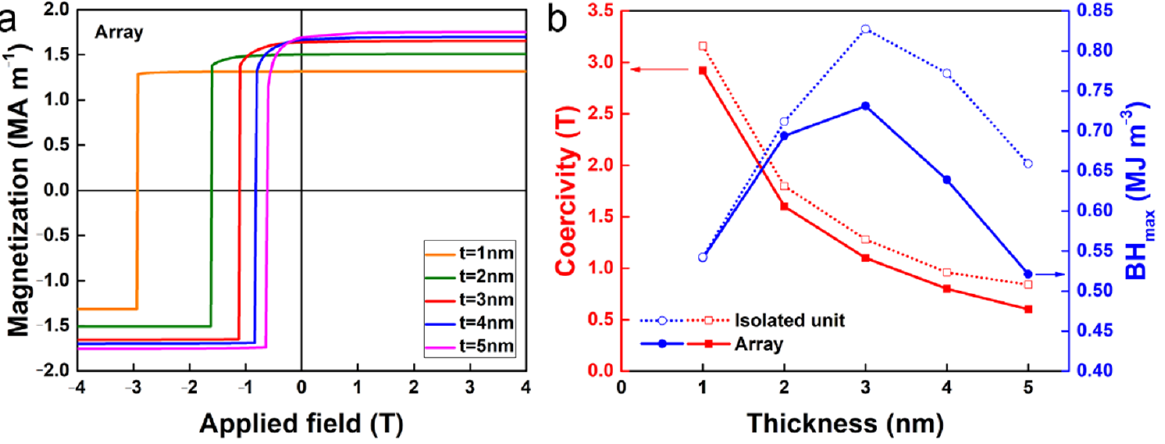
Figure 7. ( a ) Calculated demagnetization curves of the hexagonal close-packed array of core/shell cylinders. ( b ) The intrinsic coercivity and maximum magnetic energy product ( BH ) max shown as a function of the thickness of the soft magnetic shell.